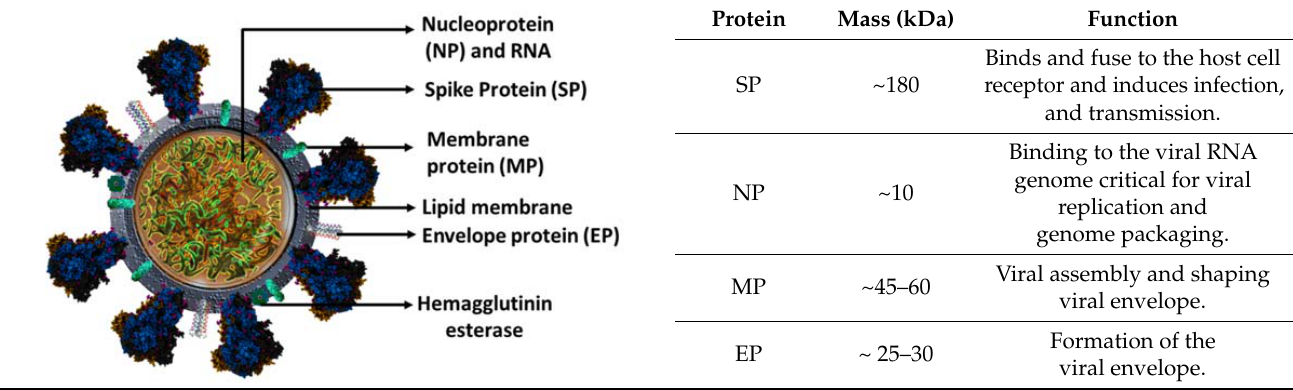
Formation of the viral envelope.